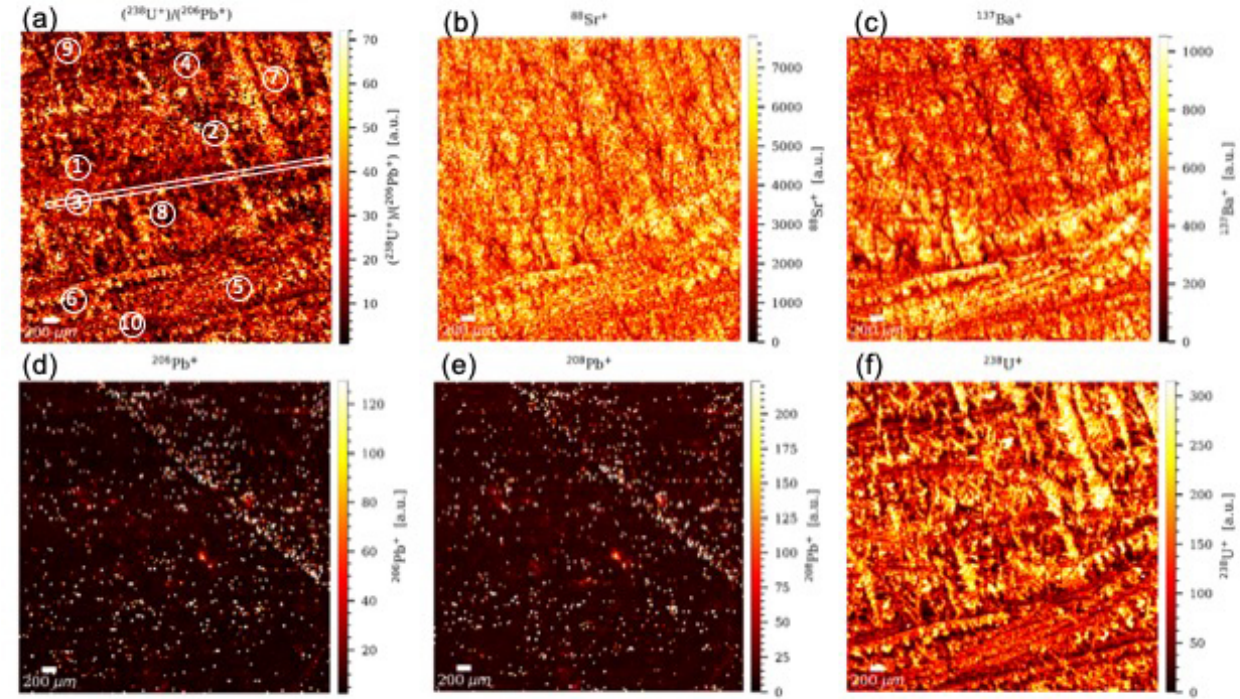
Figure 3. Signal intensity maps of ASH-15. For 238 U / 206 Pb, 88 Sr, 137 Ba, 206 Pb, 208 Pb, and 238 U (a–f) . The plotted signal was corrected for blank and analytical drift of the instrumentation. Note that each distribution map has its own signal intensity scale. The position of the regions of interest and transect is shown in (a) . The circles designating the location of the regions of interest are not to scale (data are available in Table